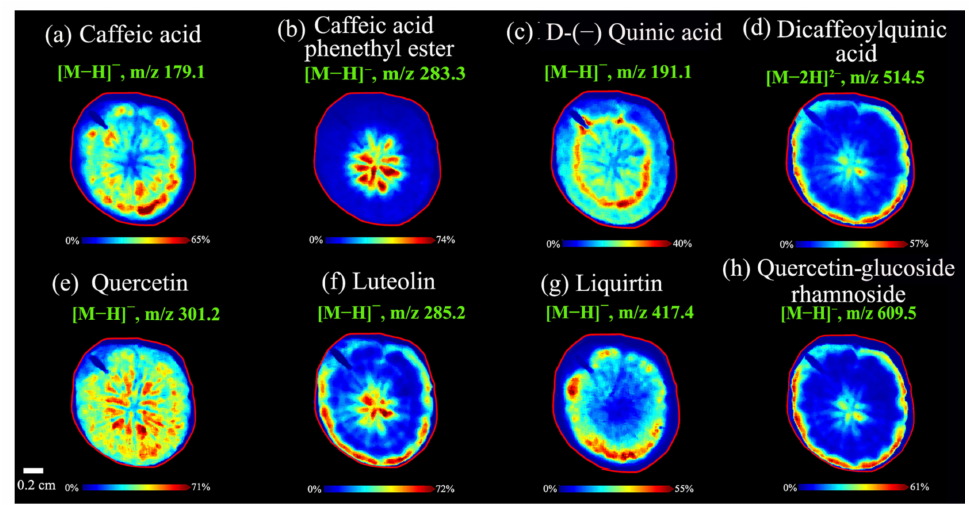
Figure 4. MALDI MS images of caffeoylquinic acids ( a – d ) and flavonoids ( e – h ) in A. lappa roots. Data were collected from the Baiji variety in negative ion reflector mode.